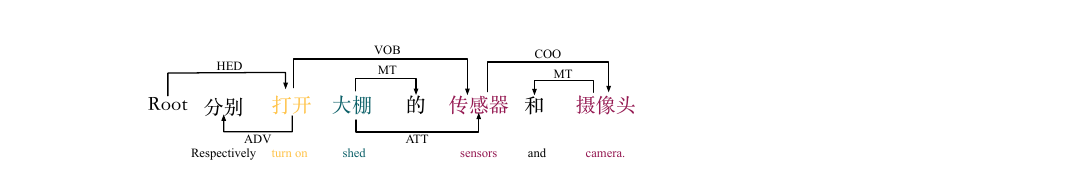
Figure 5. Example of dependency relationship.